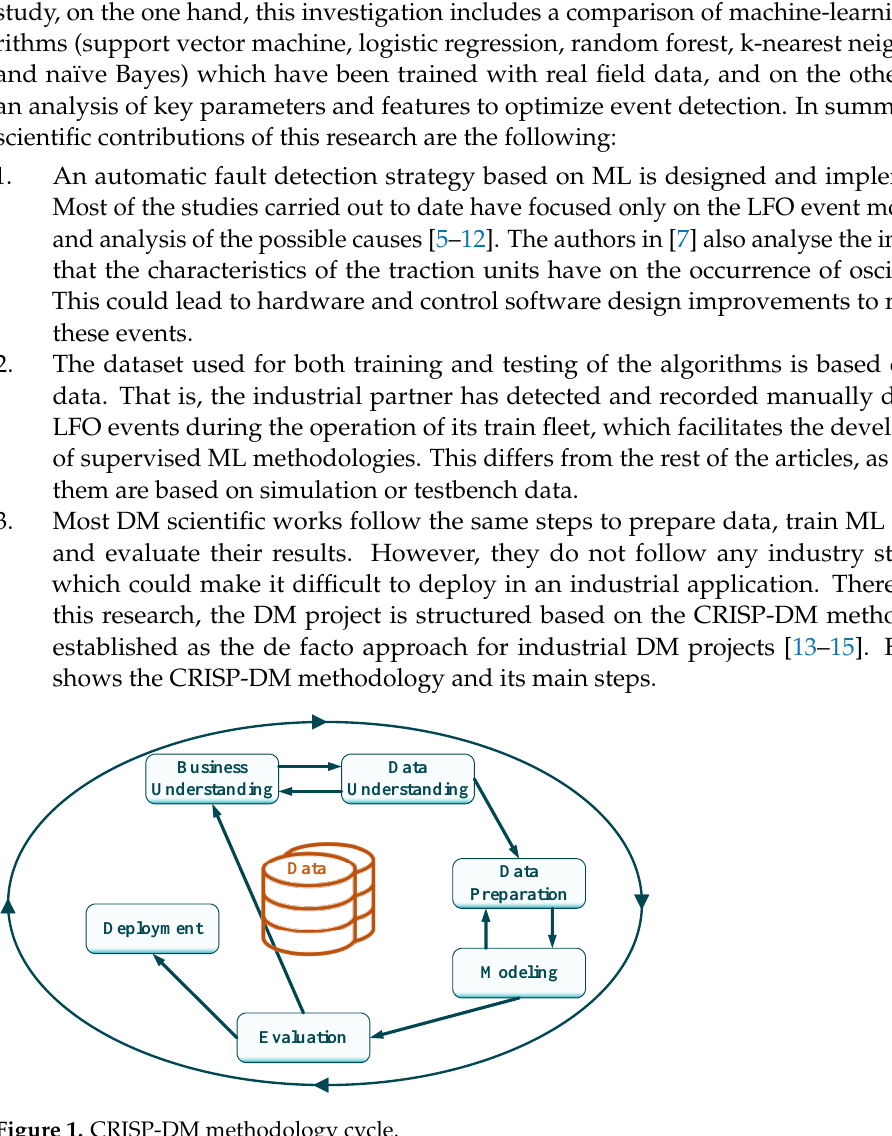
Figure 1. CRISP-DM methodology cycle.